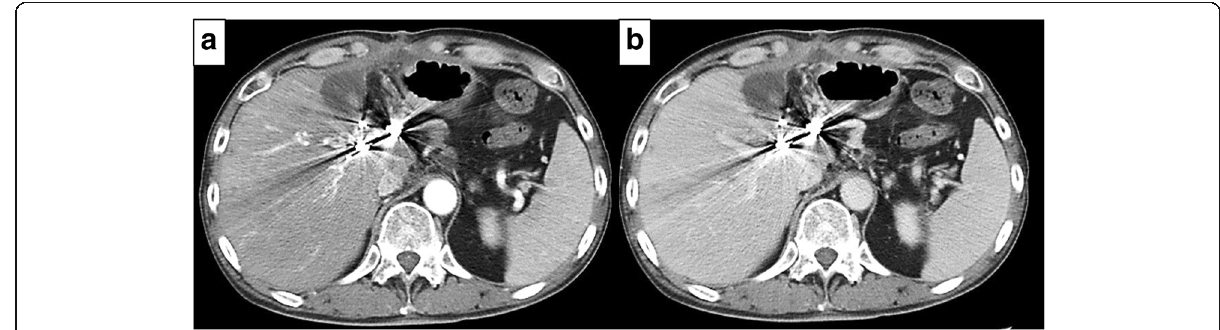
Fig. 7 Contrast-enhanced computed tomography image of the abdomen after left hepatectomy. The earlier enhancement of the portal vein disappeared in the hepatic arterial phase. a Arterial phase. b Delayed